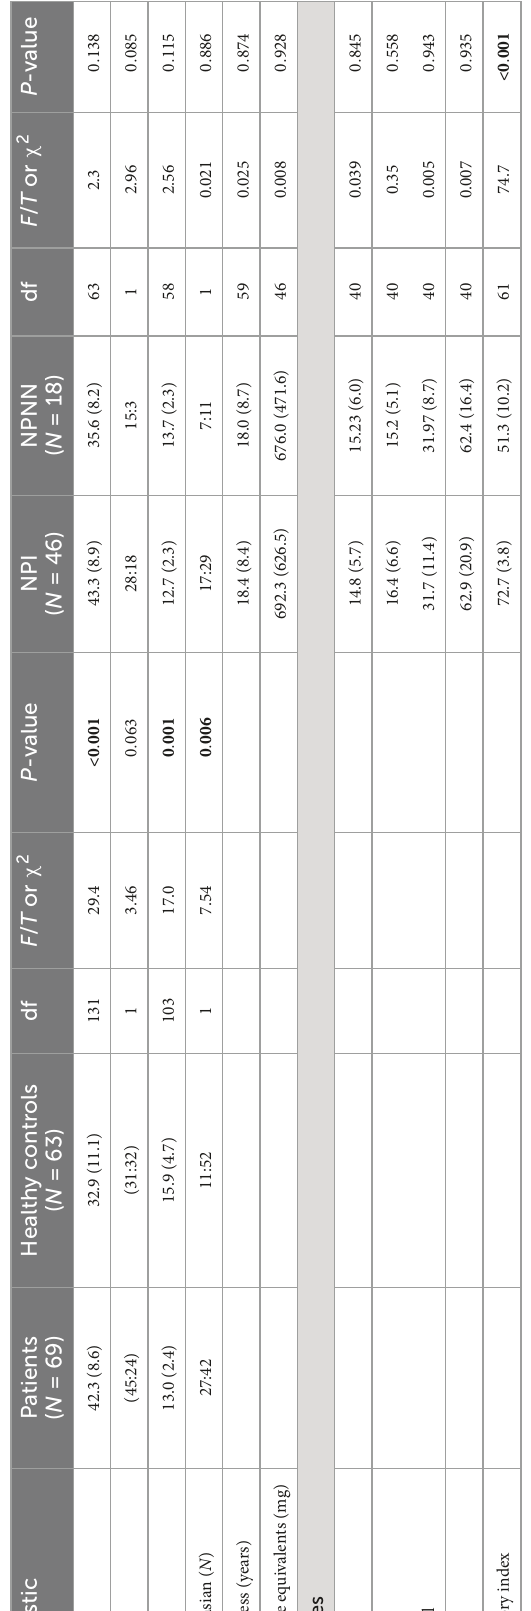
TABLE 2 Psychotropic medication at the time of MRI